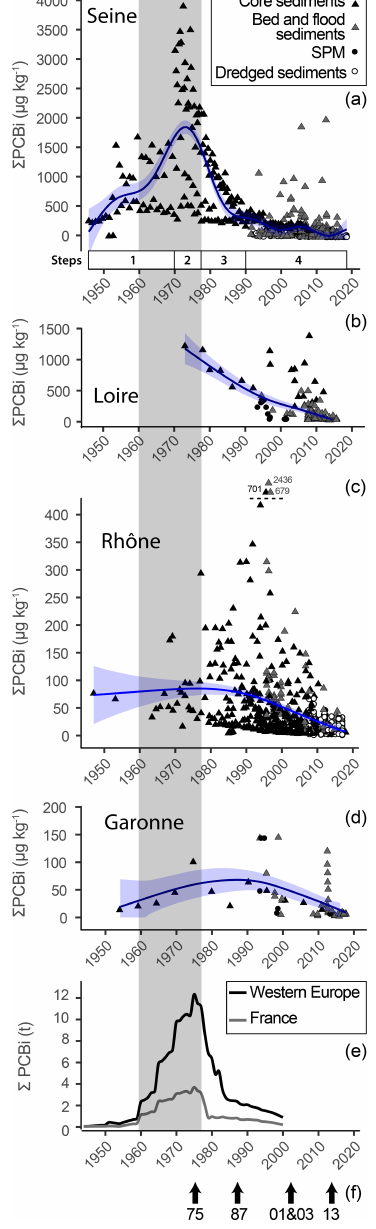
Figure 3. Estimated (cid:54) PCBi trends in fluvial sediments since 1945 in the four rivers: (a) Seine, (b) Loire, (c) Rhône and (d) Garonne. The blue curve represents the GAM modelling and the pale blue area its confidence interval. Steps 1, 2, 3 and 4 refer to the temporal trends cited in the text. (e) Comparison with estimated global emissions of (cid:54) PCBi in tonnes for France and western Europe (after Breivik et al., 2002a, 2007). (f) Regulation timeline: 75 = French restriction of PCBs in closed devices (order of 8 July 1975); 87 = prohibition of production, sale and purchase of devices using PCBs > 500mgkg − 1 (decree 87-59); 01&03 = removal of devices using PCBs > 500mgkg − 1 (decree 2001-63 and order of 26 February 2003); 13 = disposal of devices using PCBs > 50mgkg − 1 (decree 2013-301). The grey bar underlines the main period of PCB production